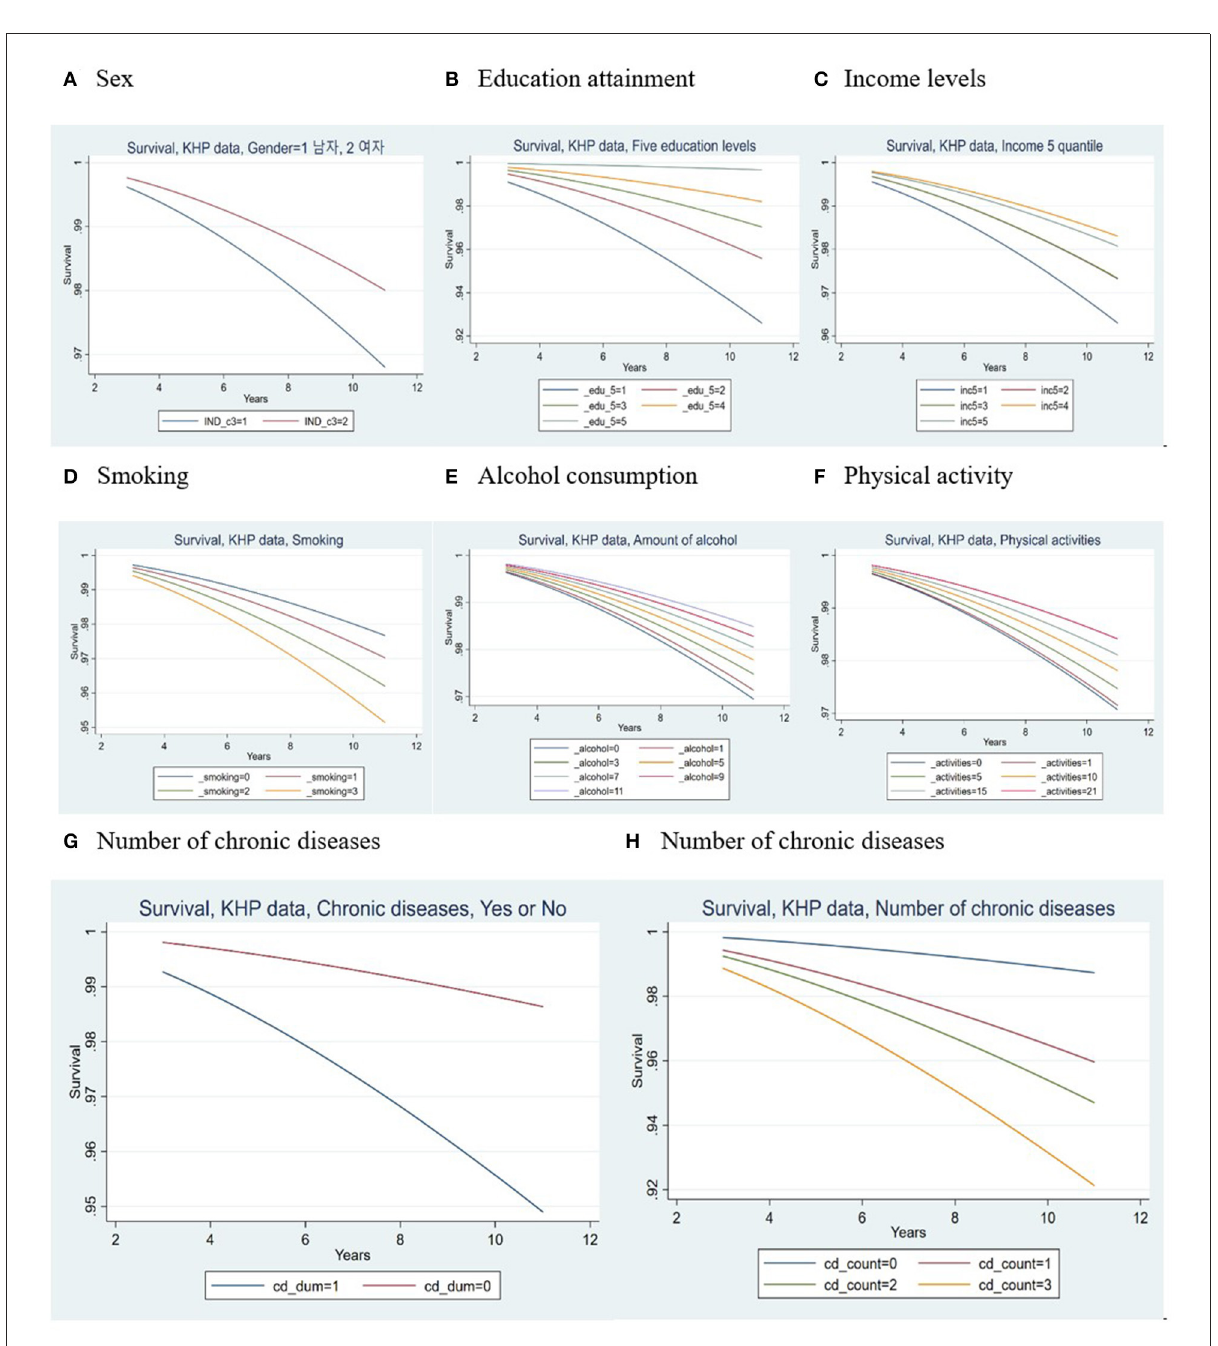
FIGURE1 PGraph representing parametric survival (Weibull) regression of newly developed disabilities. (A) Sex; (B) Education attainment; (C) Income levels; (D) Smoking; (E) Alcohol consumption; (F) Physical activity; (G, H) Number of chronic diseases.